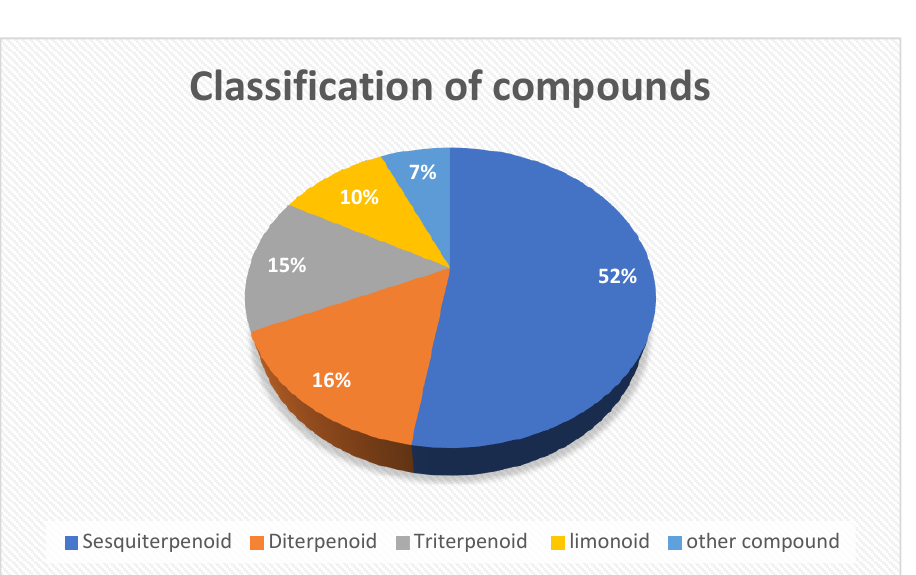
Figure 2. The distribution by groups of compounds from the Guarea genus. Table 1. Terpenoid and other compounds from Guarea Genus.